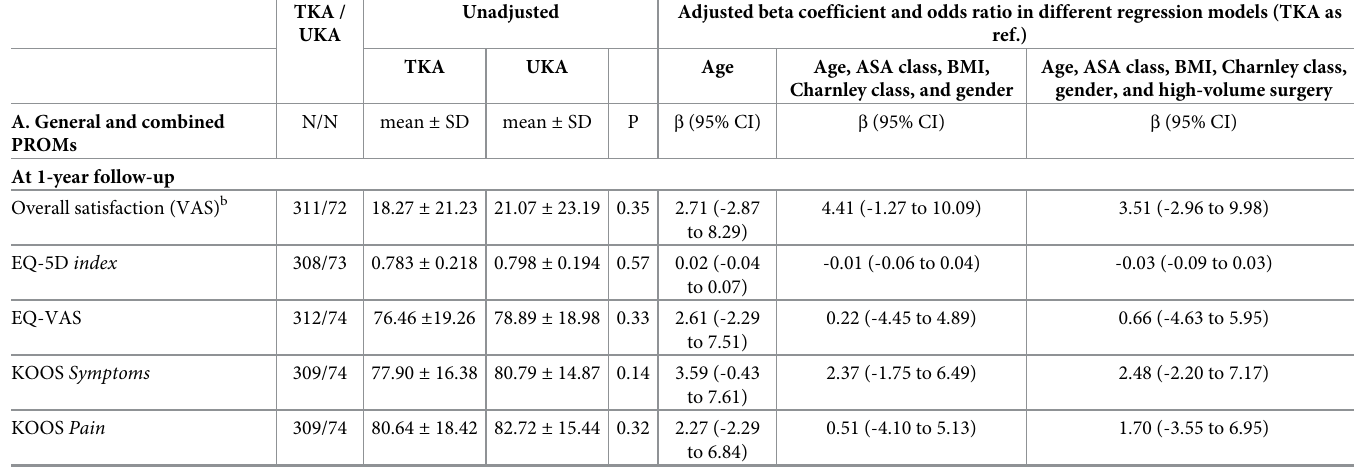
Table 2. Unadjusted absolute and adjusted relative between-group comparisons of patient-reported outcomes and complications in the TKA and UKA subgroups a . TKA / Unadjusted Adjusted beta coefficient and odds ratio in different regression models (TKA as UKA ref.) TKA UKA Age Age, ASA class, BMI, Age, ASA class, BMI, Charnley class, Charnley class, and gender gender, and high-volume